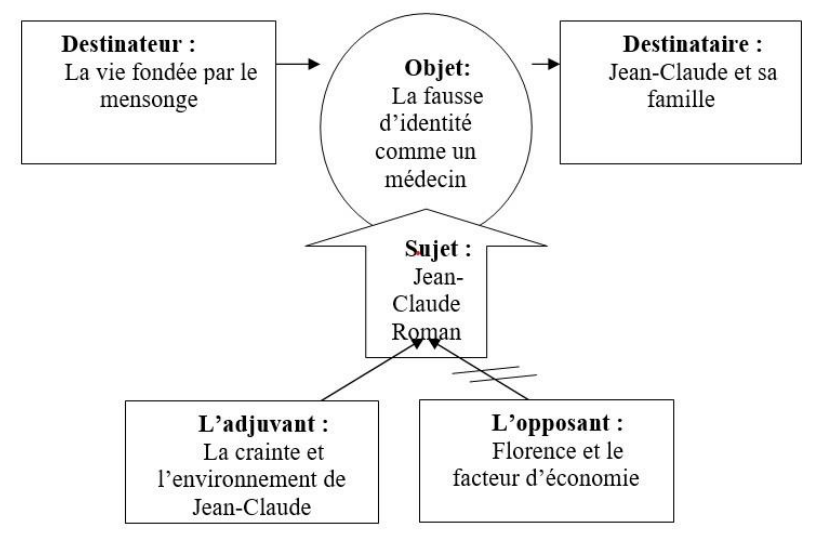
Figure 1 Le schém a actantiel du roman L’Adversaire d’Emmanuel